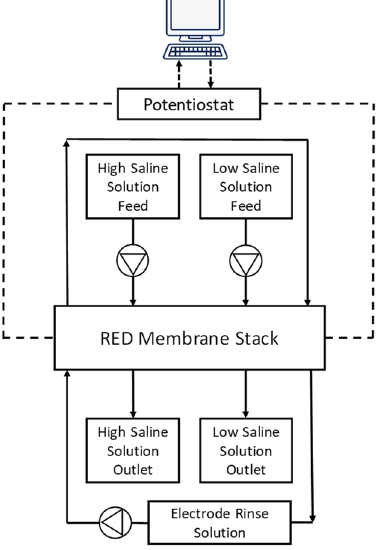
Figure 2. Flow diagram of the RED system.